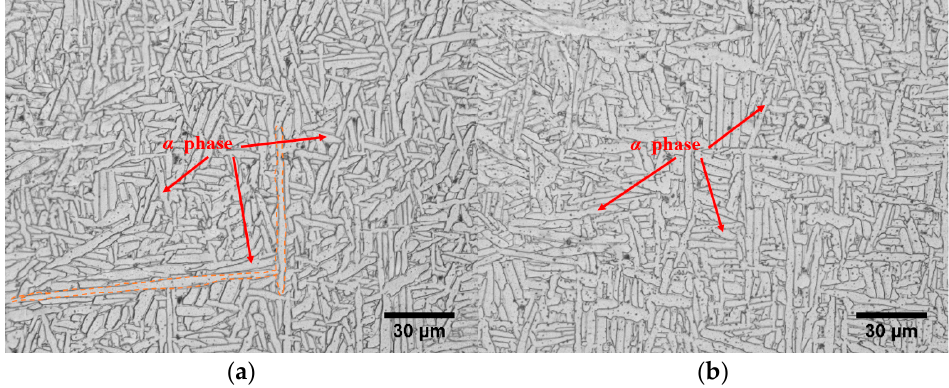
Figure 7. Microstructure of the longitudinal sections of the two groups of samples. ( a ) Group Z specimens (deposition direction). ( b ) Group X specimens (scanning direction). specimens (deposition direction). ( b ) Group X specimens (scanning